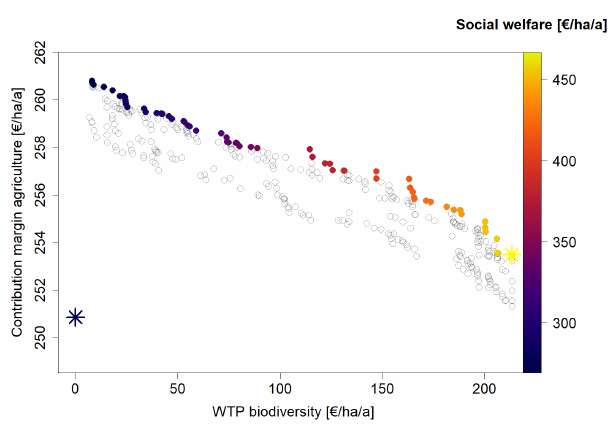
Fig. 7. Overall Pareto frontier of the optimization based on the willingness to pay (WTP) function 2. Light grey unfilled points = the sets of nondominated solutions for all seven optimization runs. Colored points and scale = the social welfare of the overall nondominated solutions starting from 250.85 € ha−1 yr−1 (status quo, dark blue) to 466.84 € ha−1 yr−1 (best solution, yellow). Blue asterisk = current state of the landscape; yellow asterisk = optimal solution with highest social welfare.